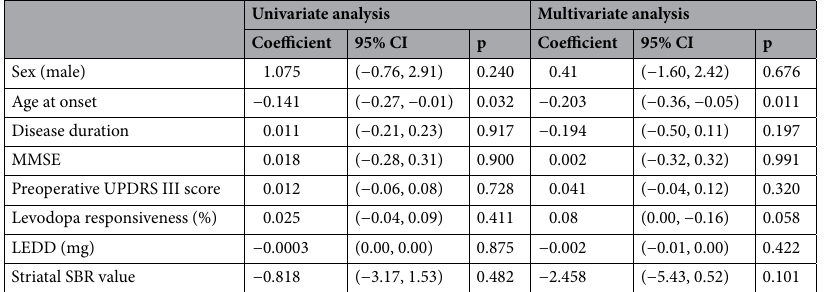
Univariate analysis Multivariate